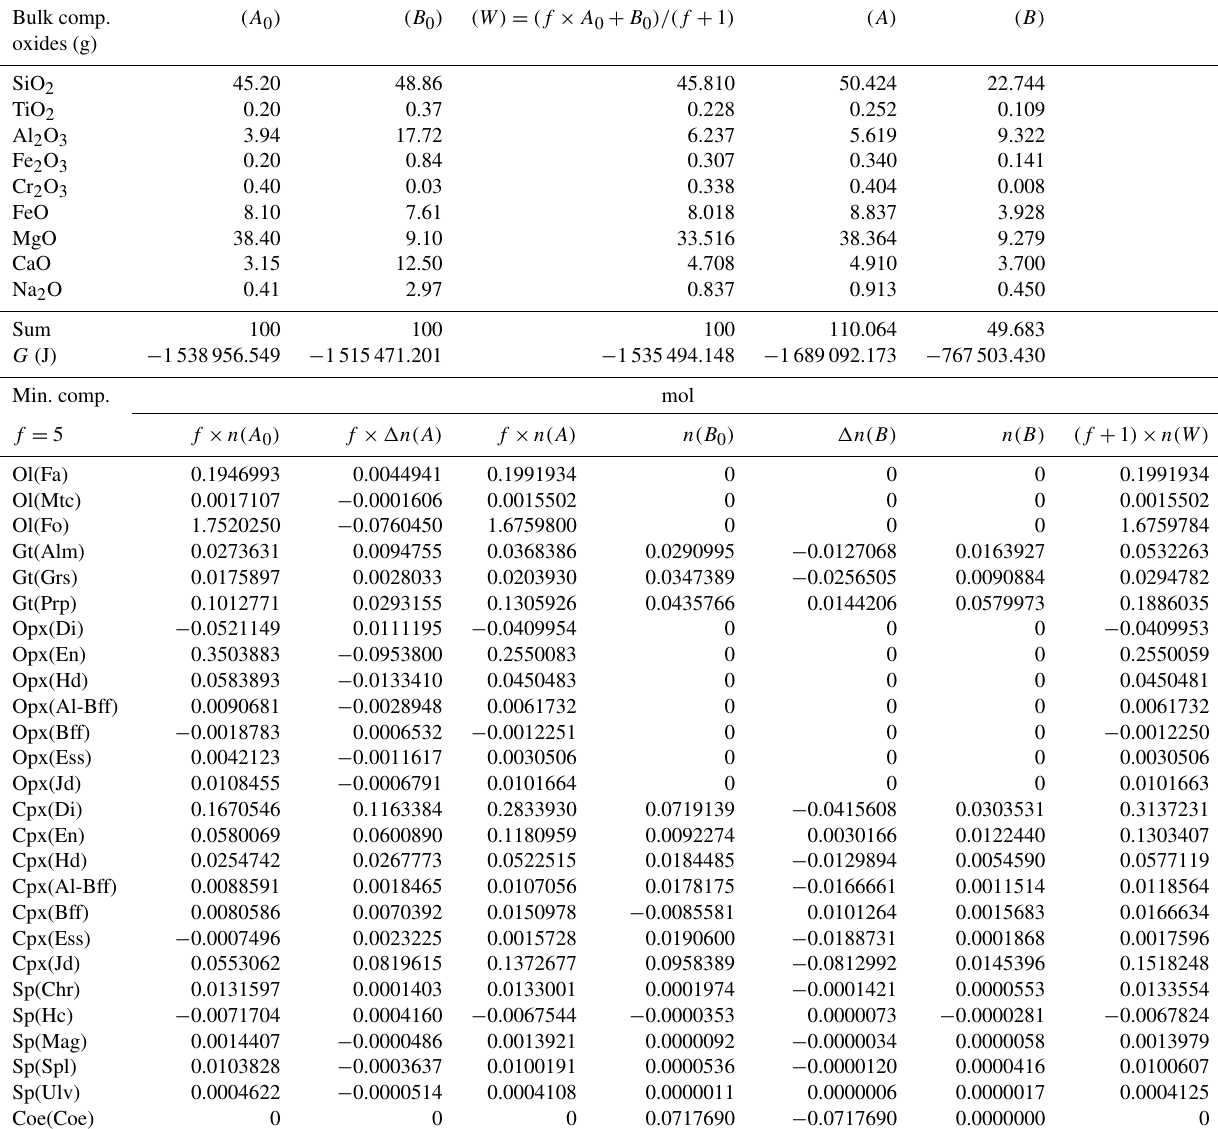
Table 6. Results from a chemical equilibration model with the initial composition of the two subsystems ( A 0 ) and ( B 0 ) analogous to the one presented in Table 3. The only difference is that the initial proportion of the whole system is f : 1 ( f = 5). Bulk